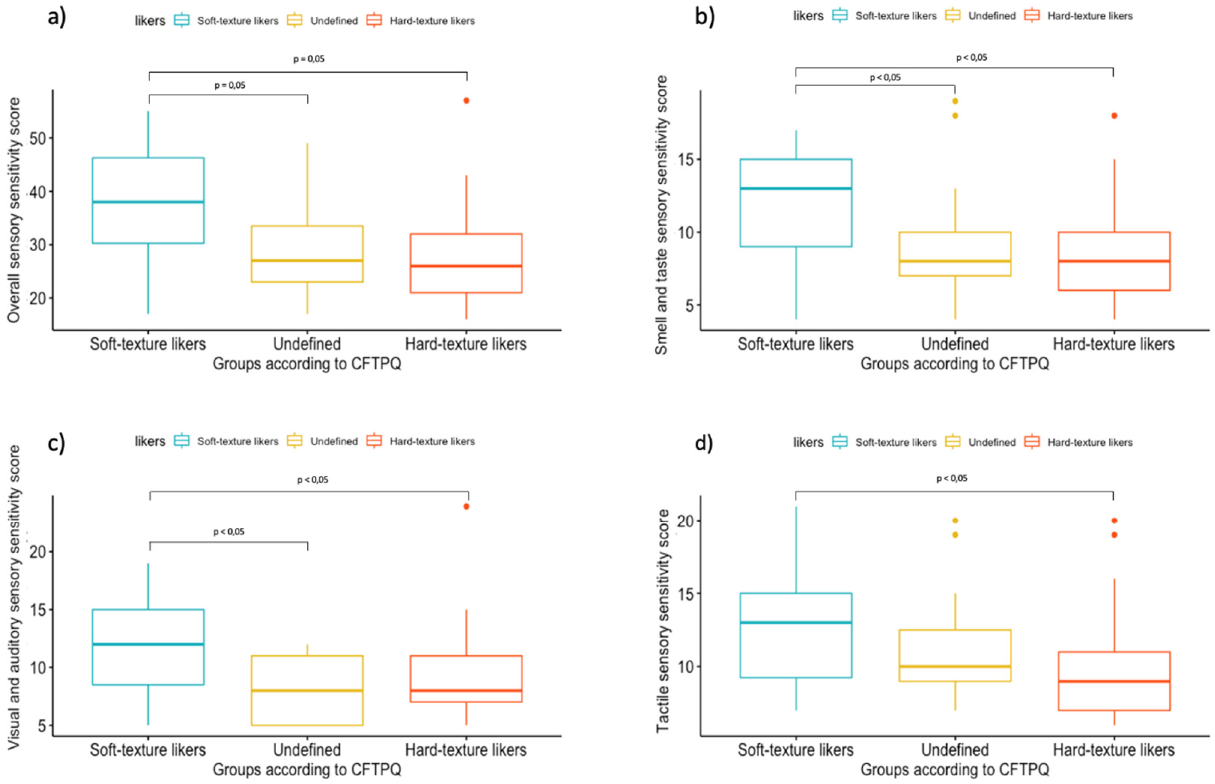
Figure 1. Analysis of variance results in a boxplot form on each Food Texture preference classification resulting for: ( a ) overall sensory sensitivity, ( b ) smell and taste sensory sensitivity, ( c ) visual–auditory sensory sensitivity, and ( d ) tactile sensory sensitivity. The individual colored dots represent outlier values.